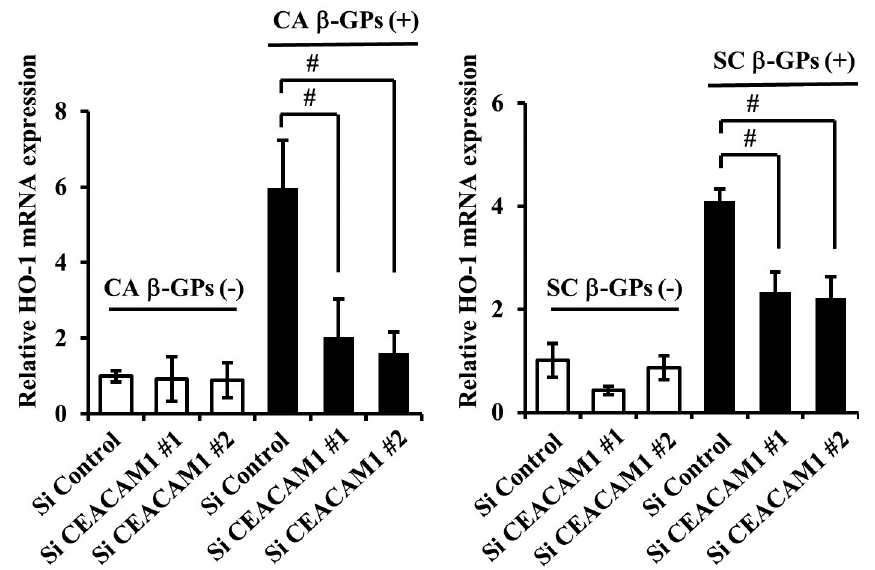
Figure 6- Effects of CEACAM1 siRNA on β-GPs-induced HO-1 in RT7 cells Cells were transiently transfected with siRNA for CEACAM1 for 48 hours, then exposed to C. albicans β-glucan-containing particles (CA β-GPs) or S. cerevisiae β-GPs (SC β-GPs) (200 μg/mL) for 12 hours. Gene mRNA levels are presented as relative to that of β-actin. Values are shown as fold increase as compared to control siRNA-transfected cells and presented as the mean ± SD of least three independent